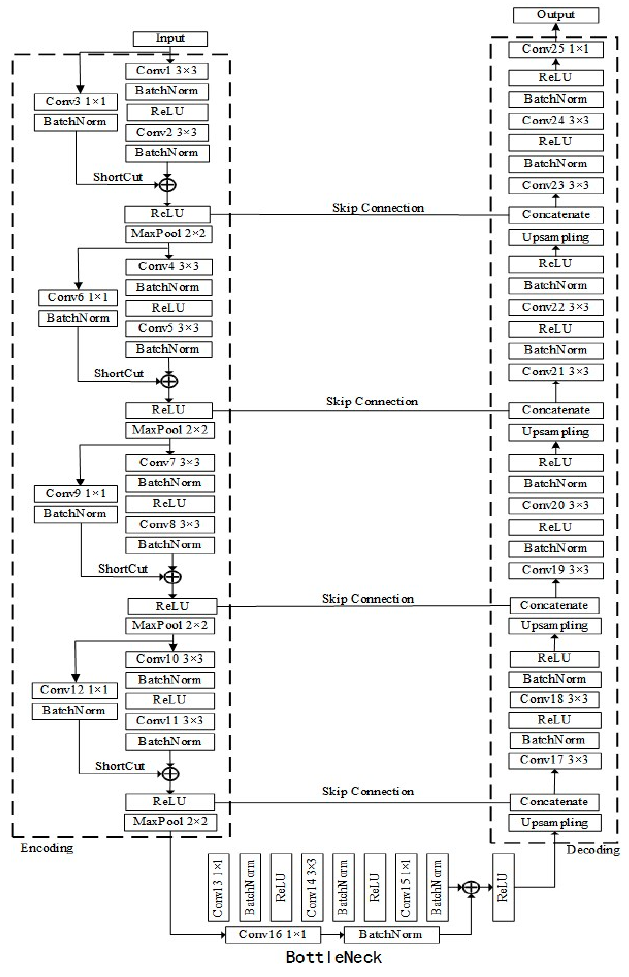
Figure 4. The structural of the deep residual U-type network model.